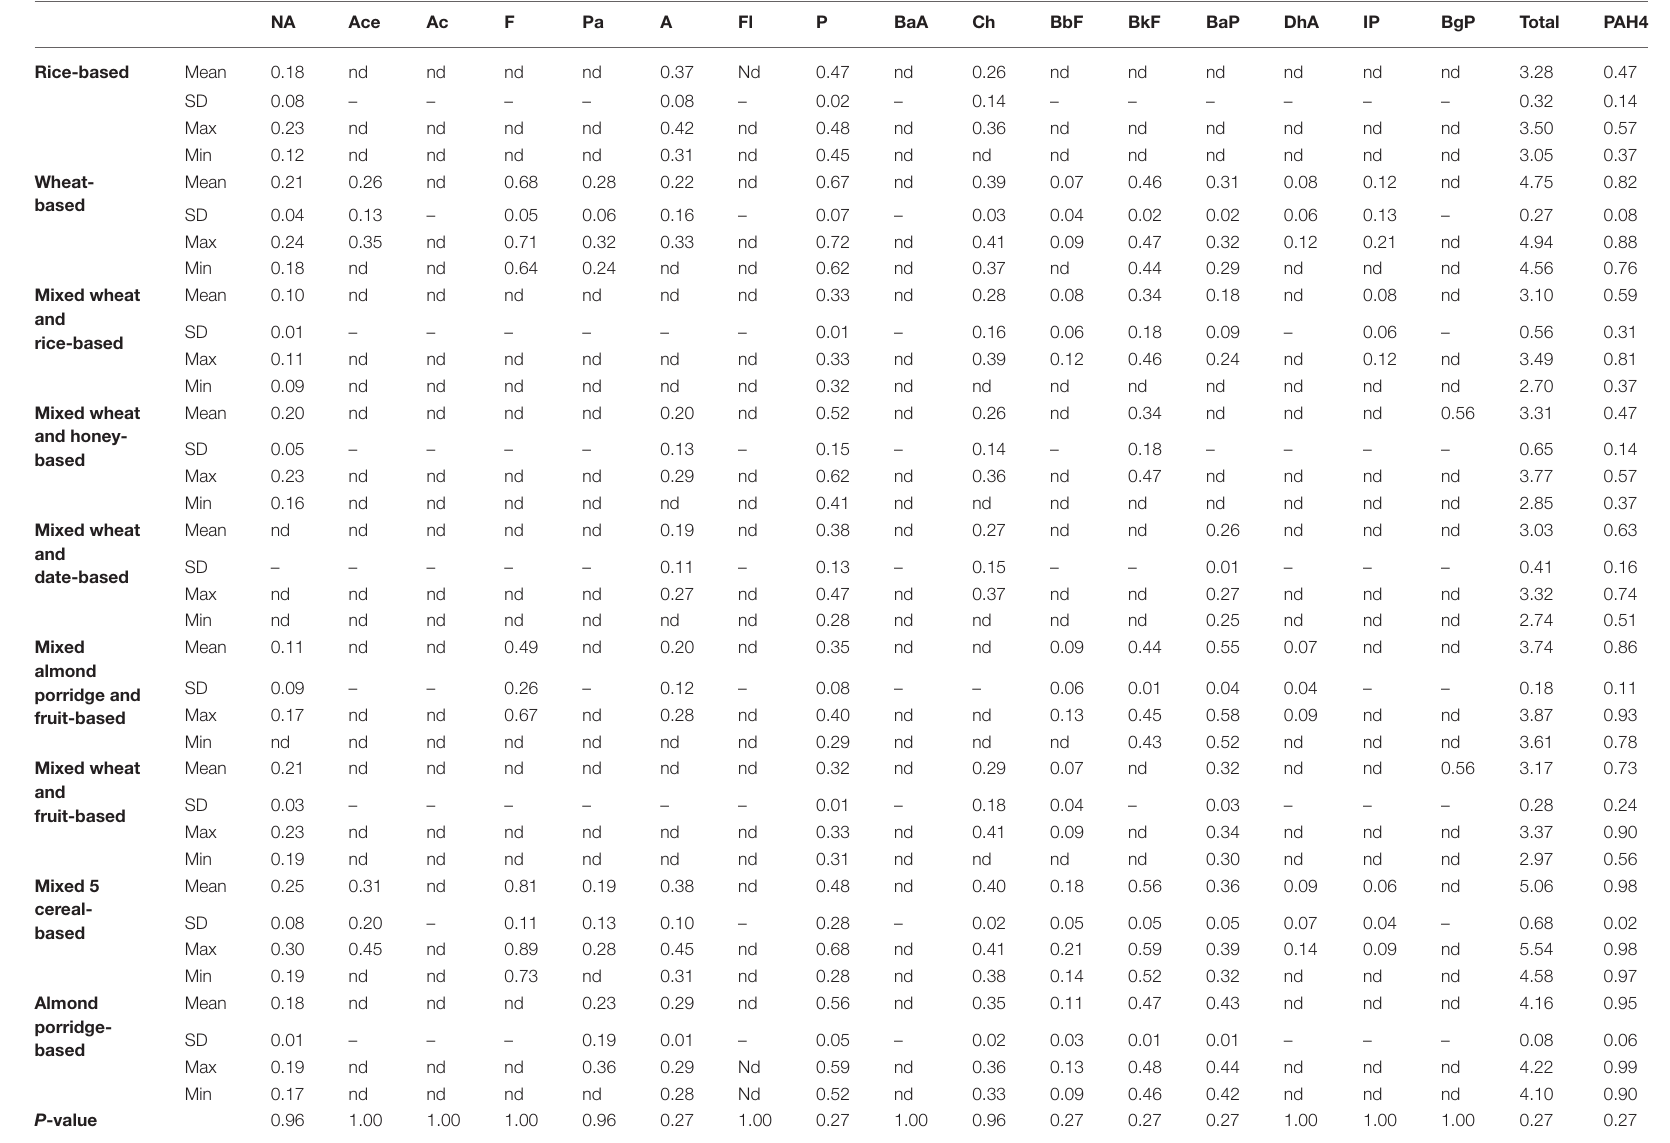
TABLE 5 | Statistical analysis of PAHs in baby food samples ( µ